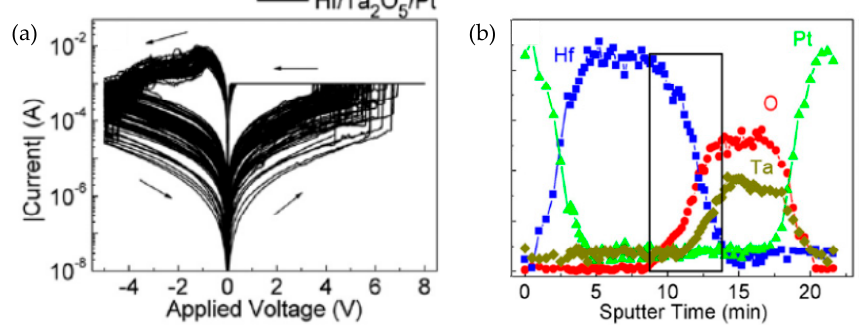
Figure 9. ( a ) Bipolar RS performance and ( b ) AES depth profiles of Hf/Ta 2 O 5 /Pt RRAM devices, reproduced from [129], with permission from AIP Publishing, 2013.